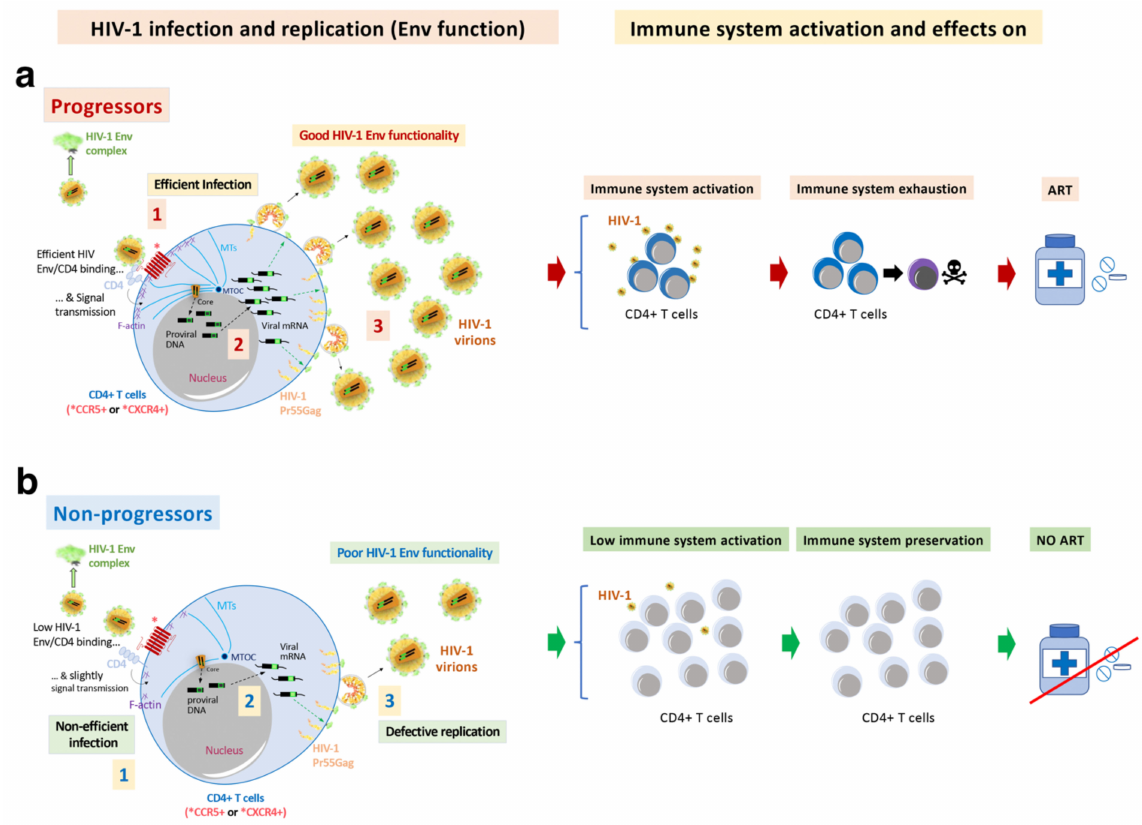
Figure 4. HIV-1 Env function correlates with clinical outcome, immune system activation, ex- haustion and cell damage: ( a ) Our works indicate that HIV-1 Envs of viruses from viremic and progressors patients (i.e., Progressors, RPs and VNPs) are associated with efficient viral